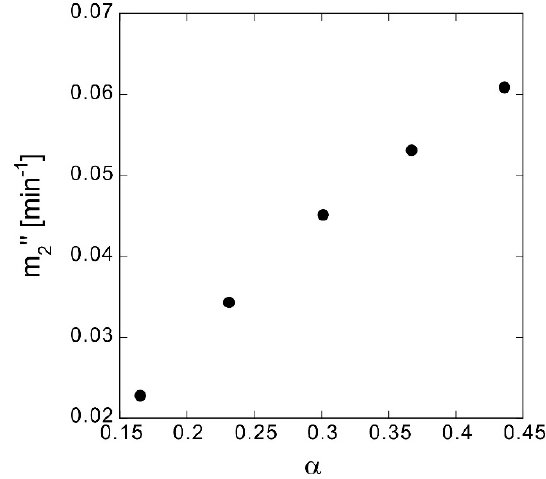
Figure 8. True elution rate m 2 ” at different porosities α .